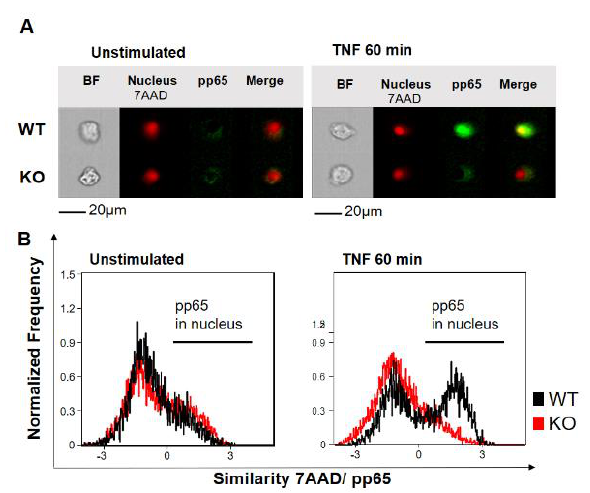
Figure 1. Y-box binding protein-1 (YB-1) is essential for tumor necrosis factor (TNF)-induced NF-κB nuclear translocation in bone marrow-derived macrophages. ( A ) Imaging flow cytometry showing one representative cell. The nucleus stained positive for 7-Amino-actinomycin D (7AAD) (red). Staining for NF-κB phospho-p65 activation (pp65) is shown with and without stimulation (green). Colocalization (yellow) indicates nuclear translocation. ( B ) Normalized frequency of wild type (WT) (black) and YB-1 knockout (KO) (Ybx1 ΔLysM ) cells (red) showing nuclear translocation of activated NF-κB p65 with and without TNF stimulation (20 ng/mL).